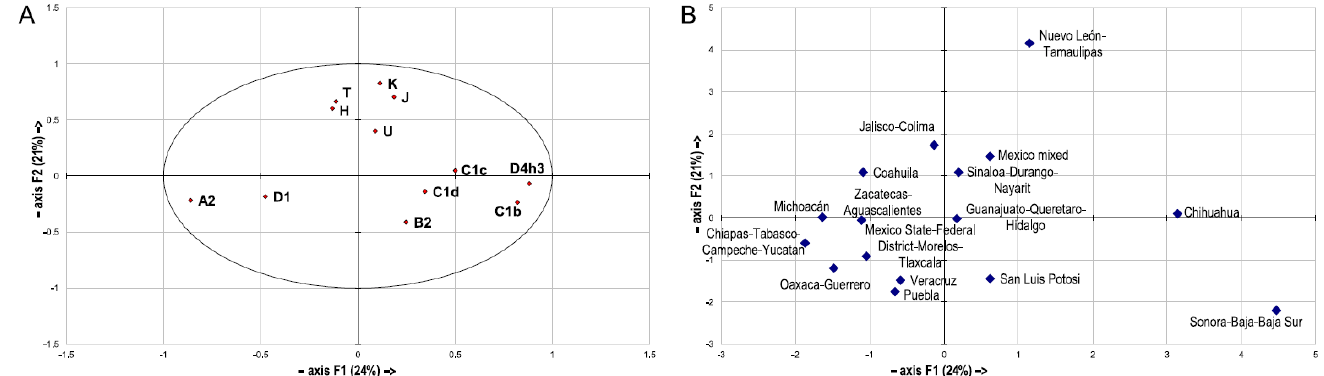
Figure 3. Principal component analysis (PCA) of mtDNA haplogroup profiles of the Mexican administrative units: ( A ) contribution of haplogroups; ( B ) genetic landscape, as depicted by PC1 (axis F1) and PC2 (axis F2). See text for details.